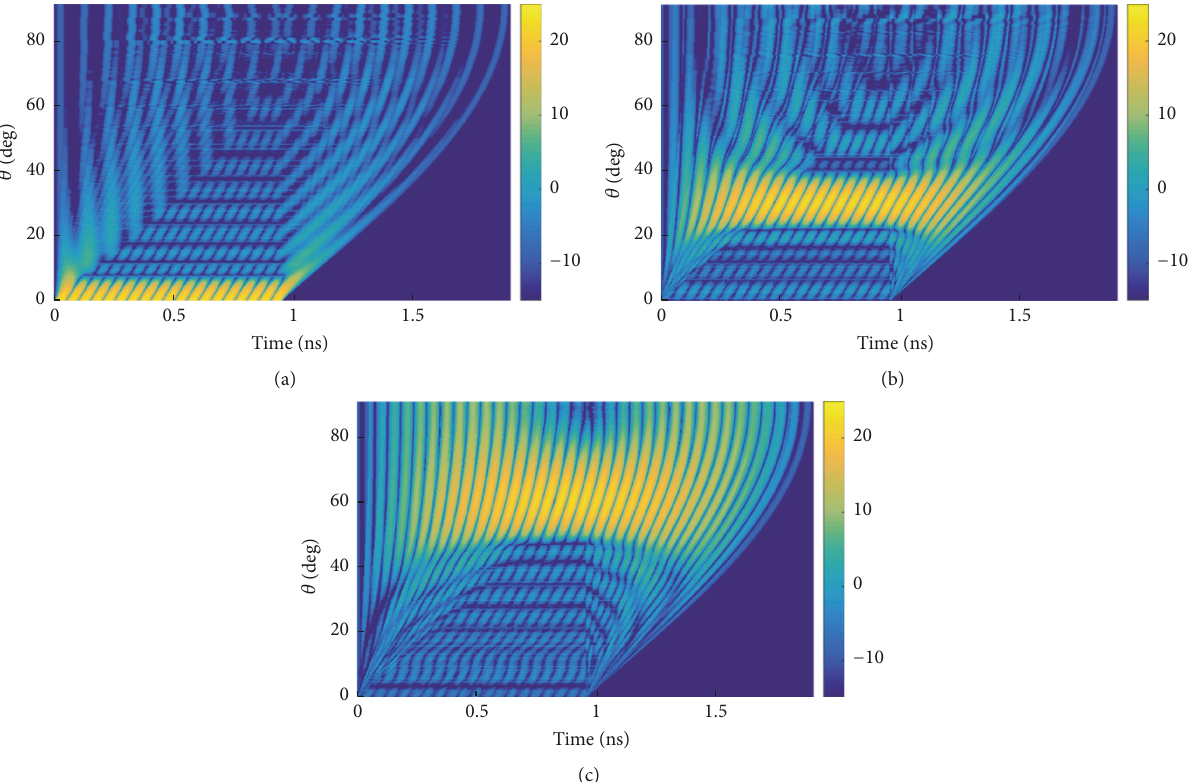
Figure 9: Pulse dispersion in a 20-element linear phased array as a function of angle when the angle of incidence equals the scan angle: (a) 𝜃 = 0 ∘ , (b) 𝜃 = 30 ∘ , and (c) 𝜃 = 60 ∘ . 𝑠 𝑠 𝑠